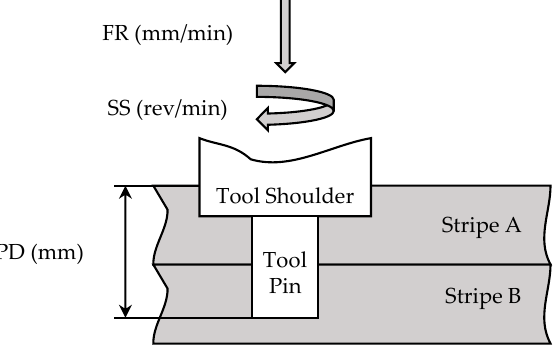
Figure 1. A schematic view of the friction stir spot welding (FSSW) tool type and process parameters.